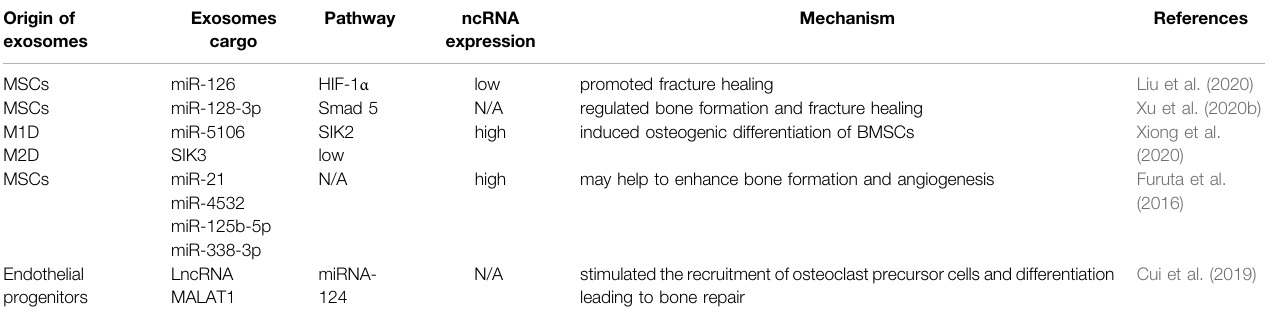
TABLE 3 | The role of exosomal non-coding RNAs in impaired fracture